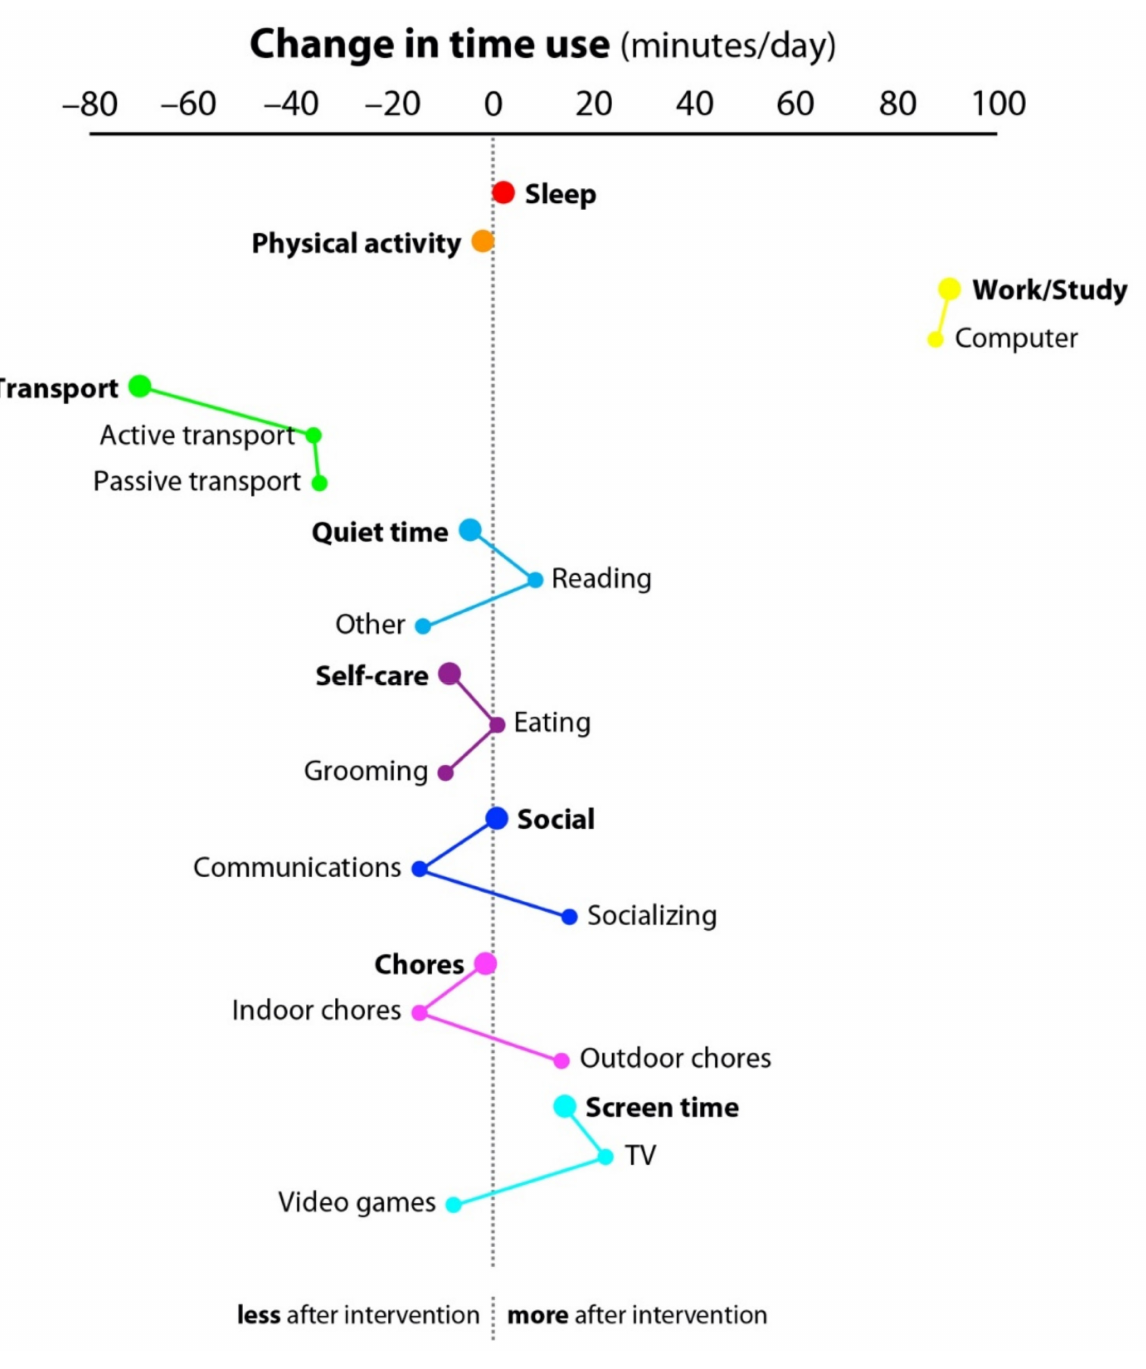
Figure 1. Changes in Time Usage across Activity Domains from Baseline to Post-Telehealth Intervention. Note: Dots to the right of the dashed vertical line indicate an increase in the time spent in the super- or sub-domains, and dots to the left of the dashed vertical line indicate a decrease in the time spent in the super- or sub-domains. Sub-domains corresponding to a super-domain are linked by lines. min/day =